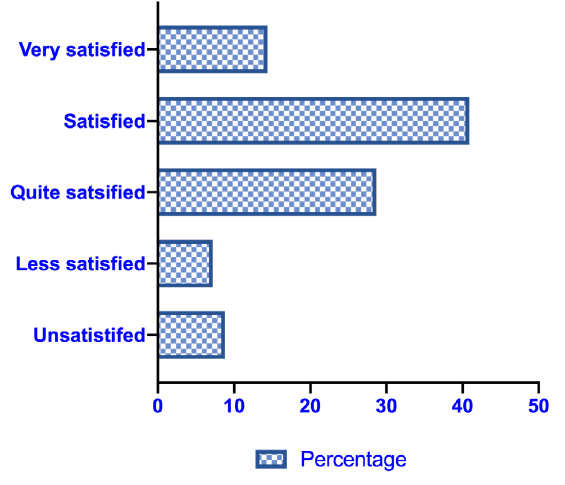
Figure 3. Satisfaction Level of Diabetes Mellitus